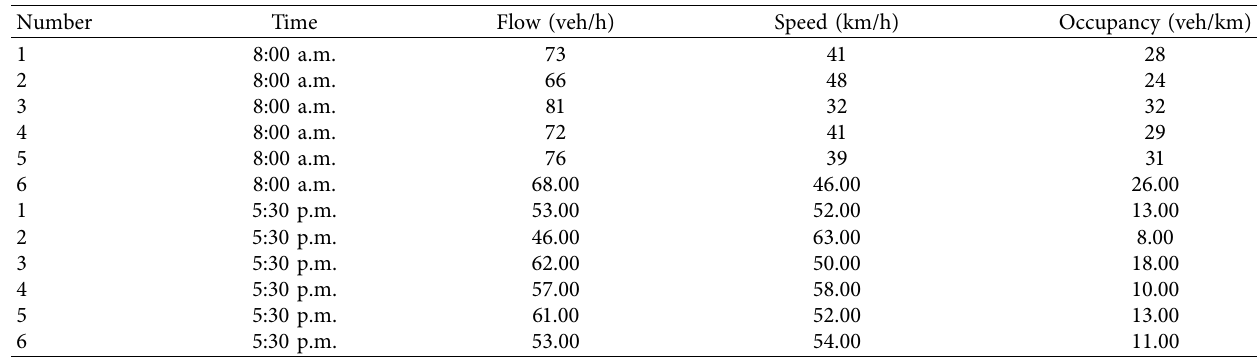
Table 3: Measured traffic